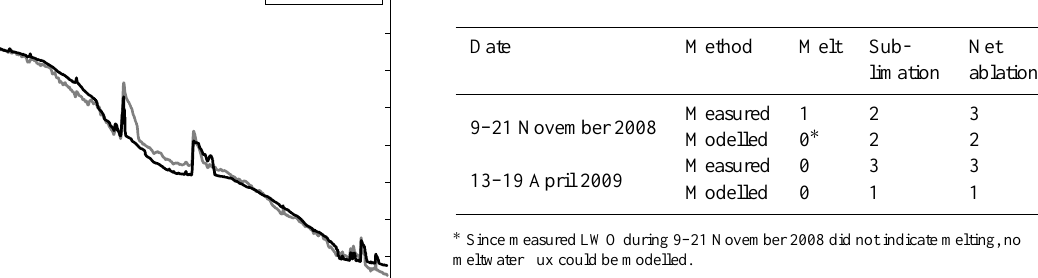
Table 2. Comparison between lysimeter and modelled ablation re- sults (mmw.e.day − 1